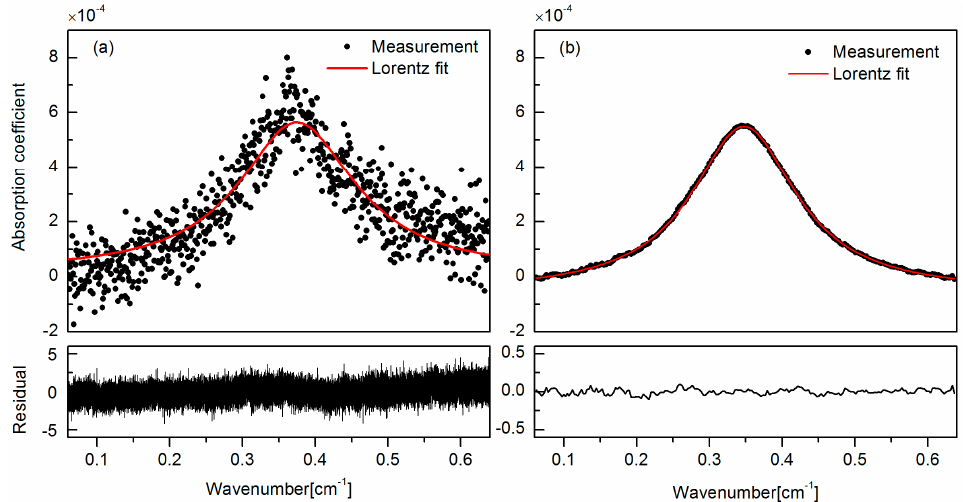
Figure 6. A comparison of absorption coefficients obtained by the use of the ( a ) conventional and ( b ) new DAS scheme for a given measurement time (1 s). ( b ) new DAS scheme for a given measurement time (1